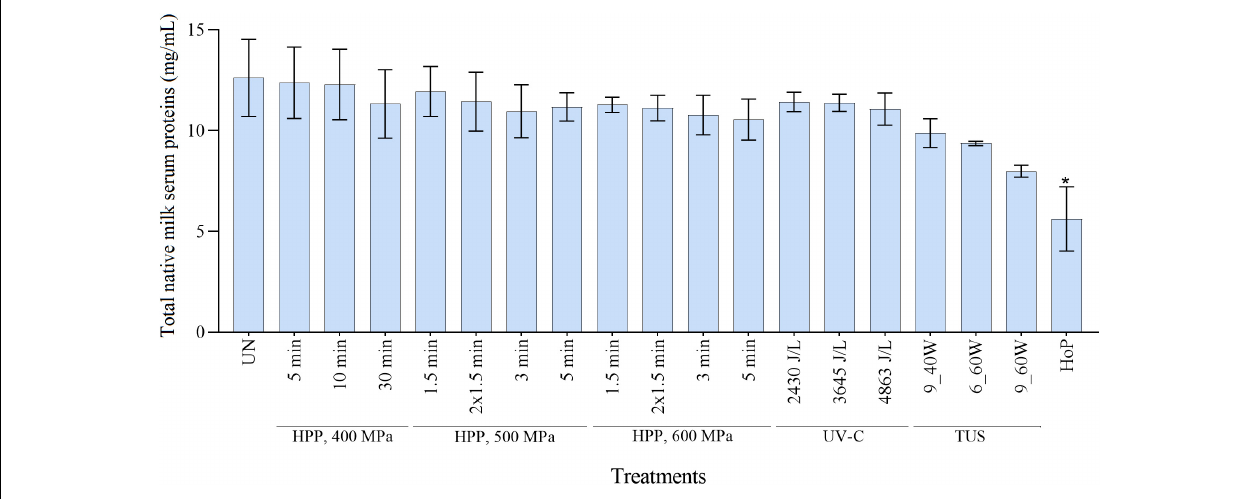
FIGURE 2 | Native milk serum protein concentration as determined with a BCA assay. The results are presented as mean ± standard deviation of two independent experiments and all analyses were performed in technical duplicate. UN represents the untreated values. *Indicates significant differences to untreated samples ( p <